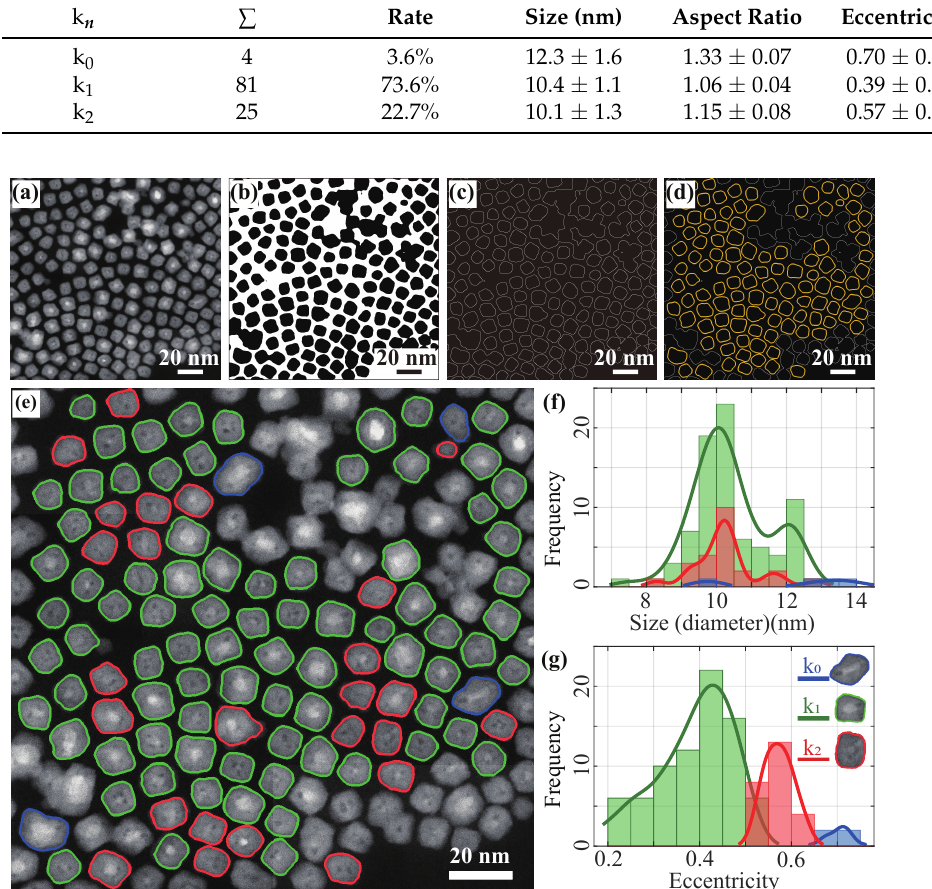
Figure 6. Image pre-processing of the iron cubes ADF-STEM image. ( a ) A high magnification, closely packed ADF-STEM image for the core-shell iron nanocubes sample. ( b ) Binary image after the dynamic background processing. ( c ) Particle edges detected by the Canny Edge detection method. ( d ) Non-convex particle contours (yellow) data collected as a dataset. ( e ) The three different shape classification particle contours are marked with three colors. ( f ) Size distribution (approximate diameter assuming the particles are spherical) of the three clusters. ( g ) Eccentricity distribution of the three